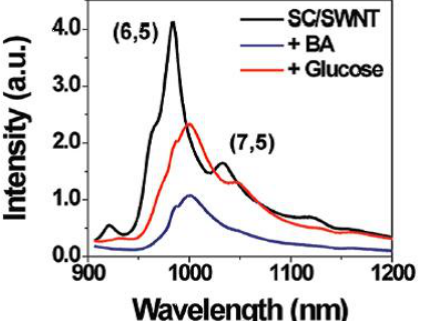
Figure 7. Modulation of the fluorescence upon binding of glucose to SWCNT-coated with 4-chlorophenylboronic acid (Reprinted with permission from [64]. Copyright 2012 American Chemical